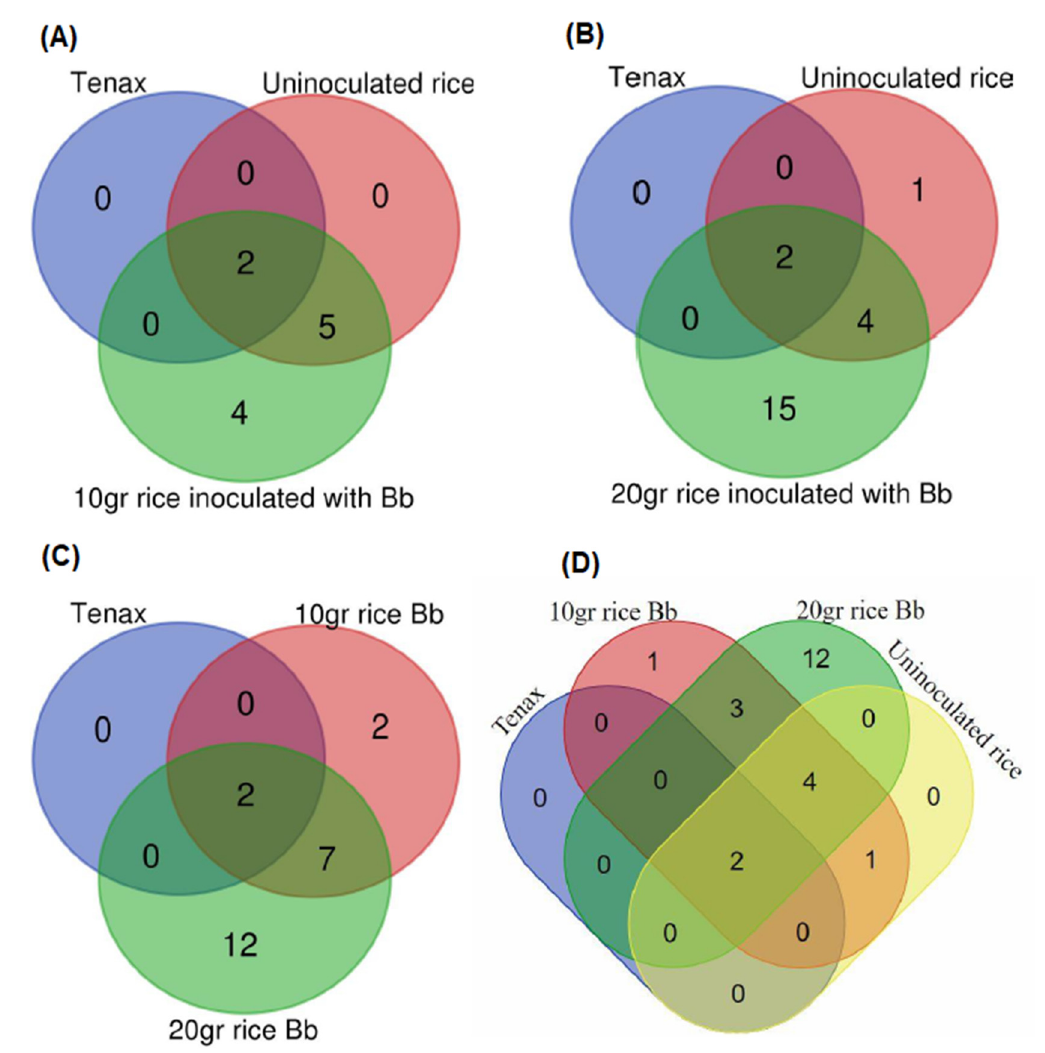
Figure 4. Venn diagram depicting the VOCs detected from the samples. ( A ) blank—green, rice—red, and 10 g of B.bassiana —blue. ( B ) blank (green), rice (red), 20 g of B. bassiana (blue). ( C ) blank (green), 10 g of B. bassiana (red), 20 g of B. bassiana (blue). ( D ) . Four overlapping samples.